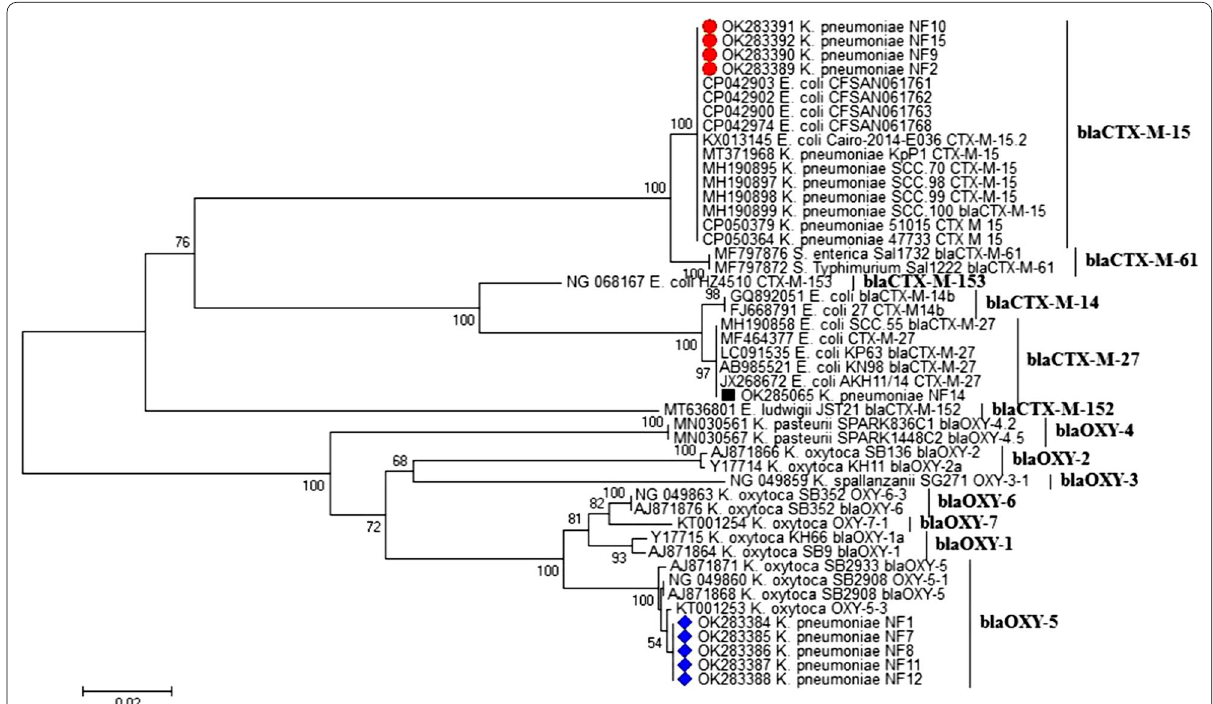
Fig. 4 Molecular phylogenetic tree of CTX-M gene sequences in 10 strains of K. pneumoniae isolated from dead foals with respiratory infection. The phylogenetic analysis was conducted in MEGA6 software [32] for the linear DNA, partial CDS of 534 bp each, with related genes in CTX‑M family using Neighbor‑joining method. Accession number is indicated adjacent to each gene. The tree is drawn to scale with branch lengths measured in the number of substitutions per site. Bootstrap values more than 50% (basing on 500 replications) are indicated at nodes. The genes of the current study were labeled with red, black and blue marks according to their relatedness with CTX‑M‑15, CTX‑M‑27 and OXY‑5